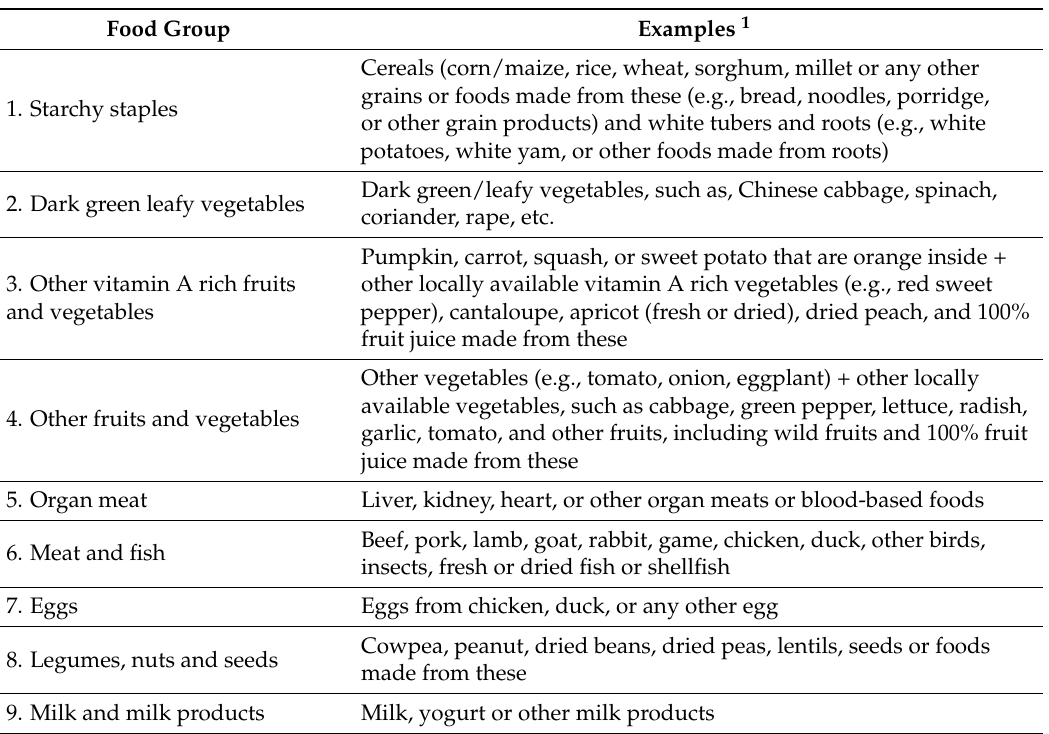
Table 1. Nine food groups of dietary diversity